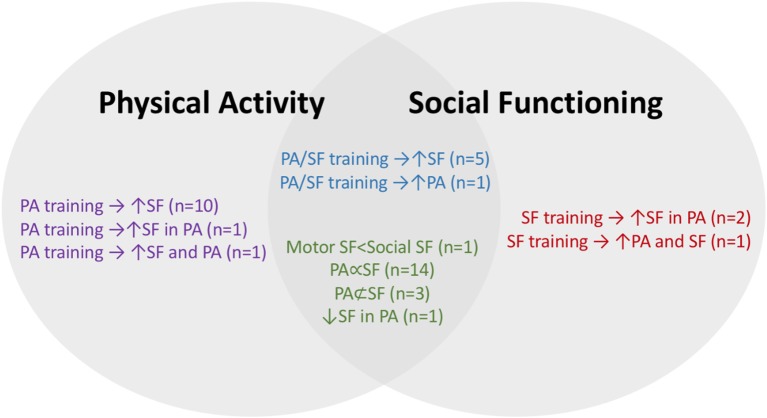
Visual representation of general summary. The key findings about PA and SF were summarized (n = 40). Study type: purple (PA intervention), blue (PA/SF intervention), red (SF intervention), green (cross-sectional). Symbol key: ↑ (increased), → (affected), ∞ (non-casual relationship), /⊂ (unclear relationship).